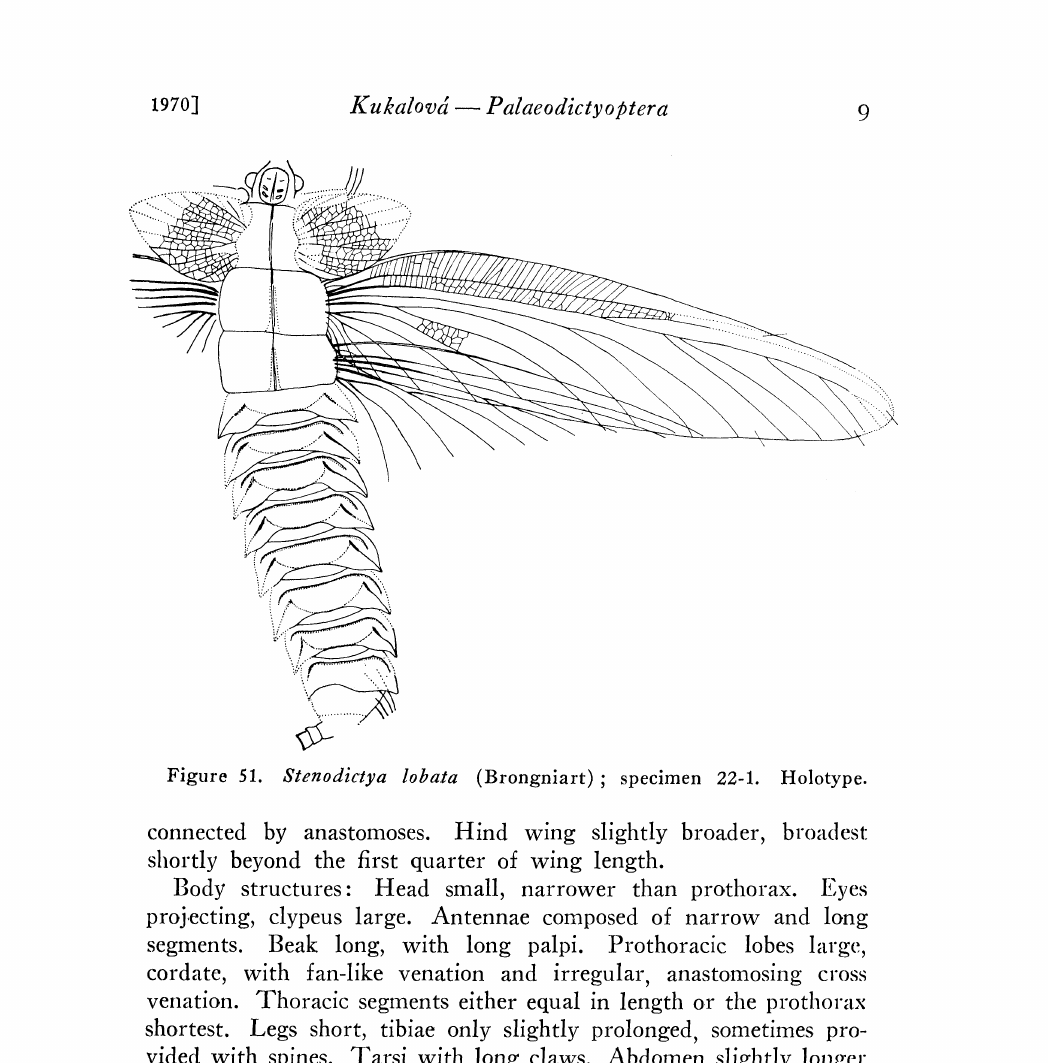
Figure 51. Stenodictya lobata (Brongniart); specimen 22-1.